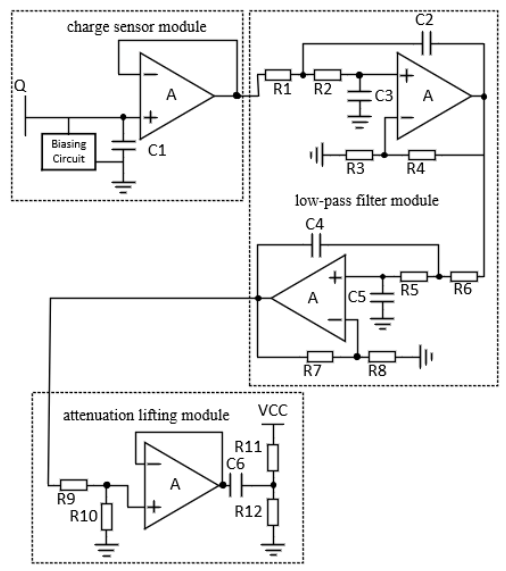
Figure 4. Schematic diagram of front-end circuit.